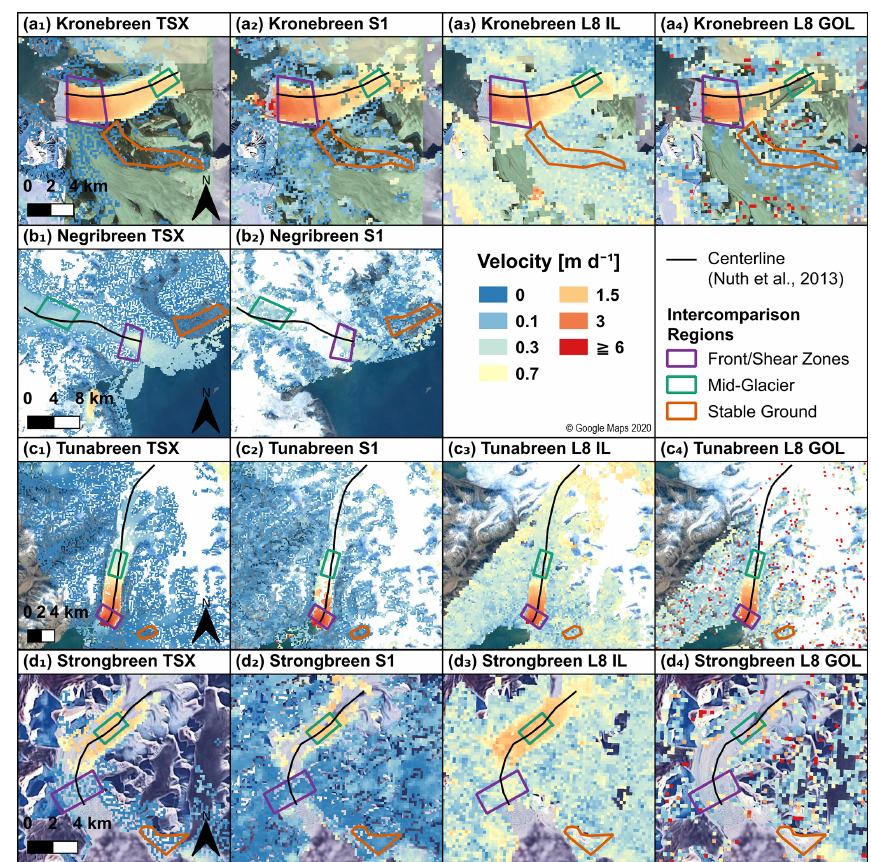
Figure 7. Comparison of scene-pair velocity fields from Sentinel-1, Landsat-8 ITS_LIVE and Landsat-8 GoLIVE with TerraSAR-X over 4 different glaciers in Svalbard. TSX: TerraSAR-X; S1: Sentinel-1; L8 IL: Landsat-8 ITS_LIVE; L8 GOL: Landsat-8 GoLIVE. The dates of acquisition are listed in Table 1. Background: © Google Maps